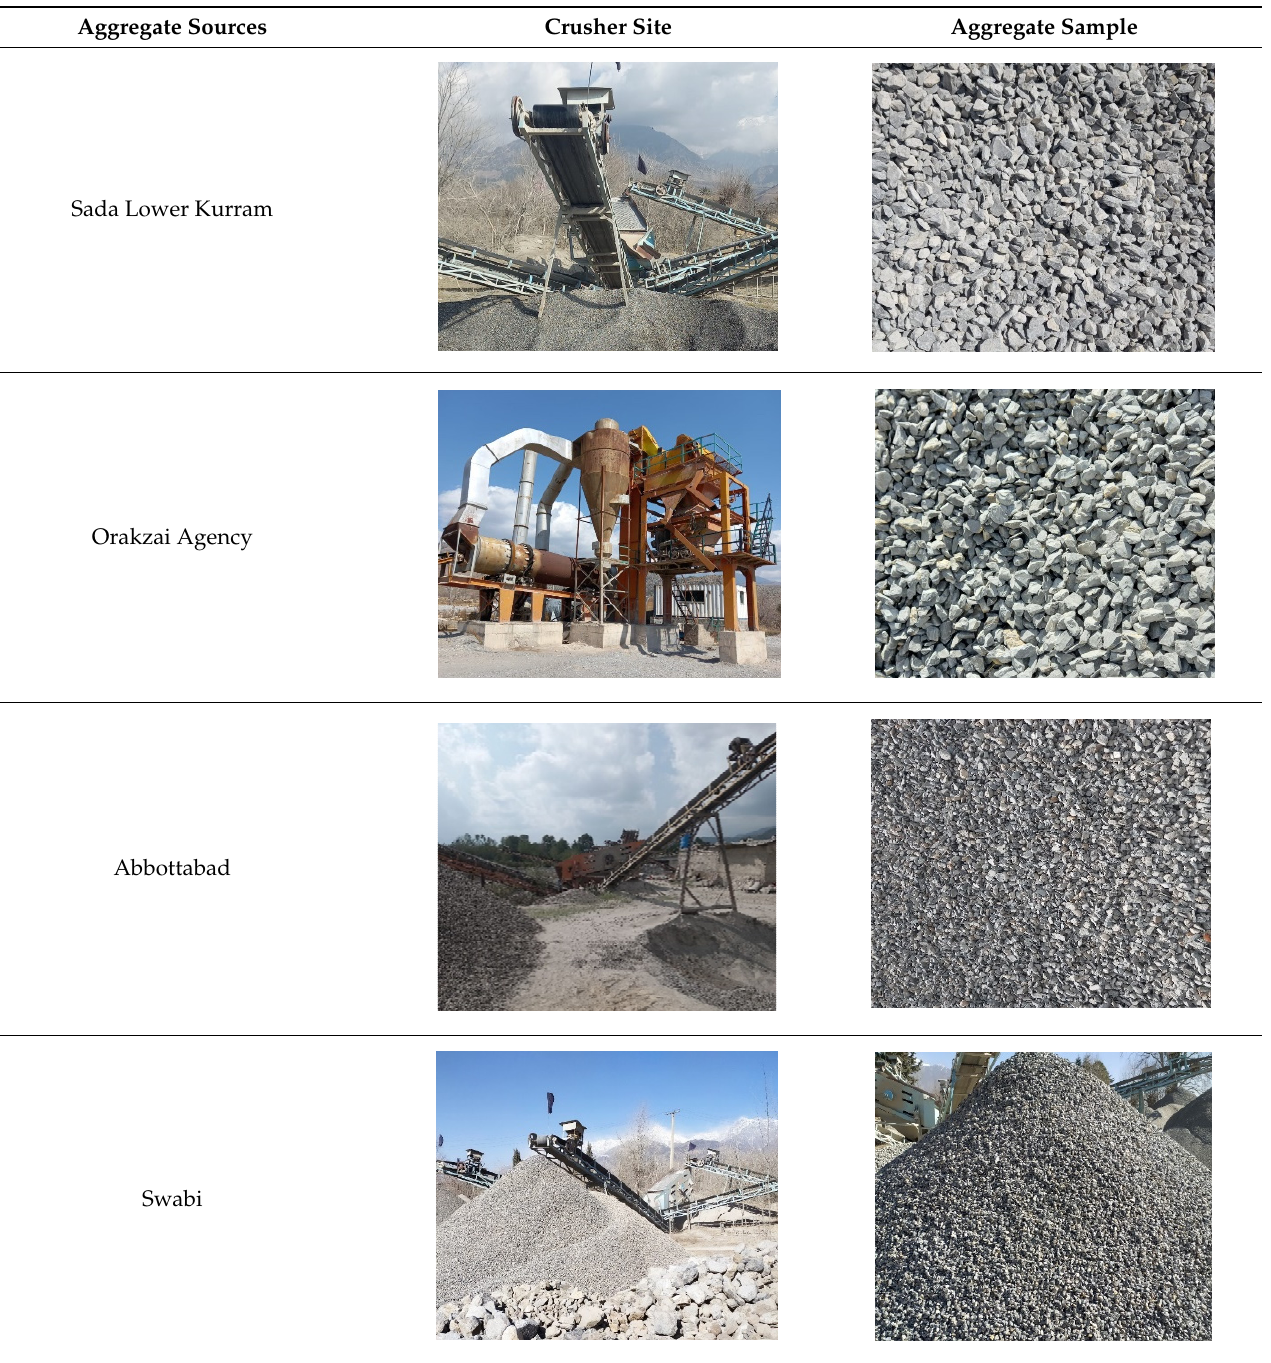
The mixture was prepared using one part cement and 2.25 parts graded aggregates, while maintaining a water-to-cement ratio of 0.47 as per ASTM C1260 [8]. Using an electric mortar mixer, mortar was thoroughly mixed, and specimens were cast. Mortar bars (25 mm × 25 mm × 285 mm), cubes (50 mm × 50 mm × 50 mm) and prisms (40 mm × 40 mm × 160 mm) were cast in two layers and compacted thoroughly. Five specimens were cast for each tested aggregates source at each testing ages. To prevent moisture loss, a plastic covering was placed over the specimens until they were demolded after 24